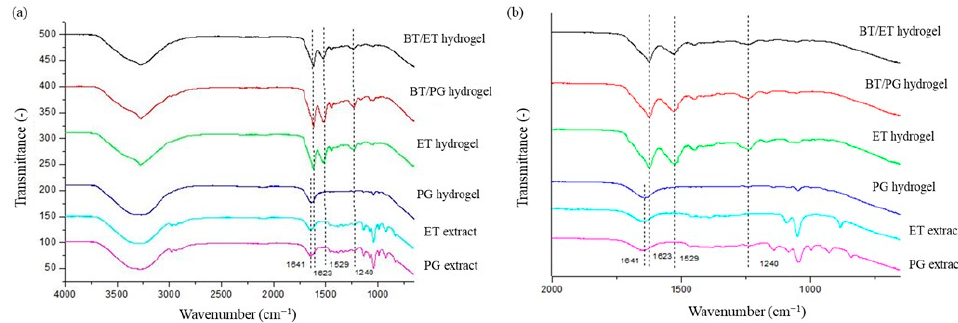
Figure 4. FTIR spectra of hydrogels and barbatimão extracts in the 4000 a 650 cm −1 region ( a ) and amplification in the region from 2000 to 650 ( b ).